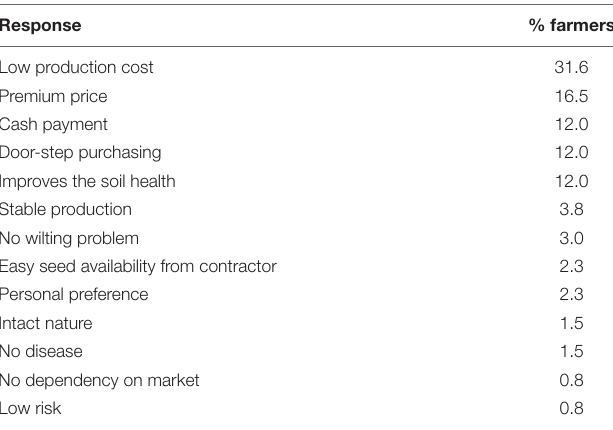
TABLE 3 | Scenarios for shifting from conventional to organic farming practices. Sr.